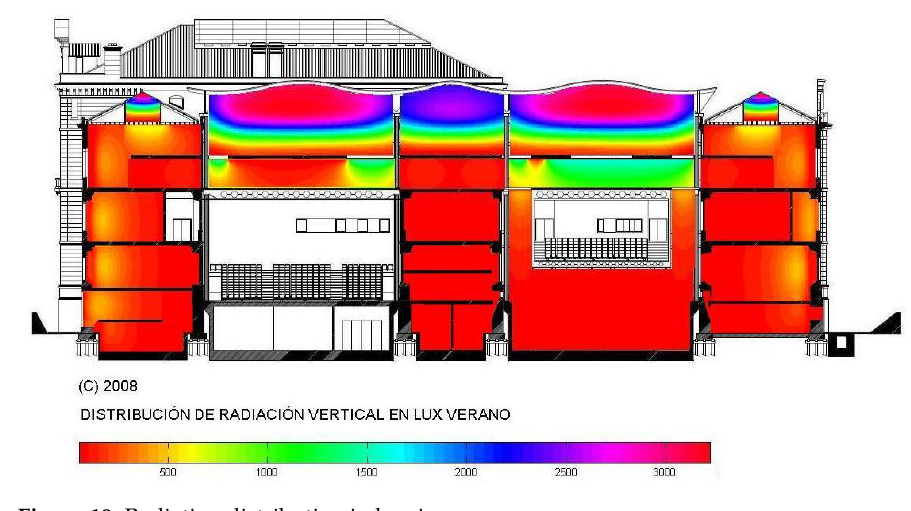
Figure 18. Radiation distribution in lux, in summer.